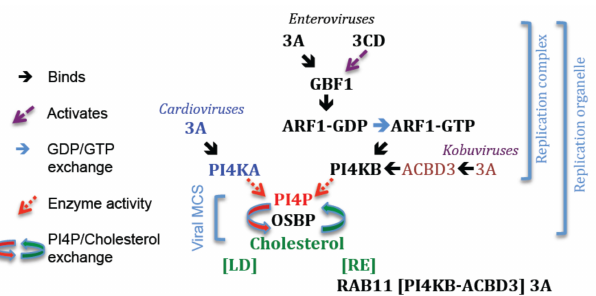
Figure 4. Key steps in forming RO enriched for PI4P and cholesterol. Cardioviruses; PI4KA is recruited to RO by a direct interaction with 3A. Kobuviruses; PI4KB is recruited to RO when in a complex with ACBD3 and 3A. Enteroviruses; How PI4KB is recruited to RO is unclear. The roles of 3A, 3CD and GBF1 in recruiting PI4KB to RO are discussed in the main text. At RO, PI4P recruits OSBP, which then drives exchange of PI4P for cholesterol. Cholesterol may be supplied by lipid droplets (LD) or derived from endocytosed cholesterol. For the enteroviruses this involves 3A (at Table 1. at recycling endosomes (RE) and may involve PI4KB and ACBD3. GBF1, Golgi brefeldin A–resistant guanine nucleotide exchange factor 1; ARF1, ADP-ribosylation factor 1; PI4KA, Phosphatidylinositol 4-Kinase III α ; PI4KB, Phosphatidylinositol 4-Kinase III β ; PI4P, Phosphatidylinositol 4-phosphate; OSBP, Oxysterol-binding protein; MCS, membrane contact